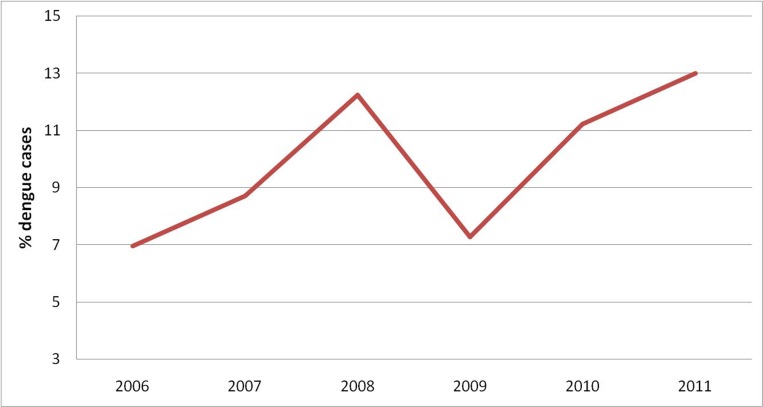
Percent cases in West Zone of Delhi (2006–2011).